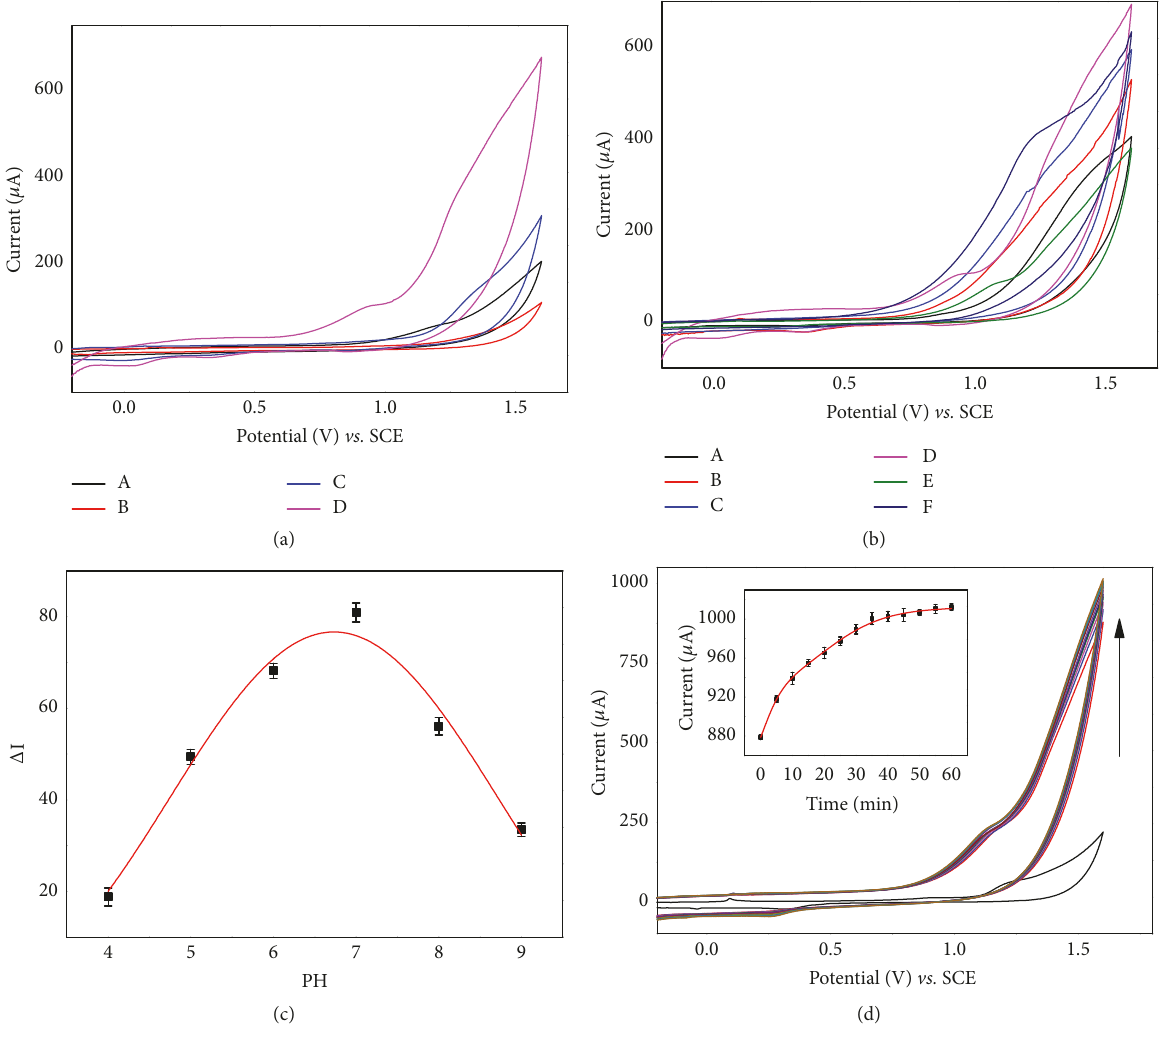
Figure 5: (a) CVs of different GCE under the absence (A and B) and presence (C and D) of 5mM H 2 O 2 in N 2 -saturated 0.1 M PBS (pH = 7.0) at a scan rate of 50mVs -1 . (A) Bare GCE (B and C) np-AuNPs/GCE, and (D) 4-carboxy-TEMPO-np-AuNPs/GCE. Optimization of experimental conditions: (b) CVs of the TEMPO -np-AuNPs/GCE in different pH values at the range of 2.0 ∼ 9.0 and (c) the relationship between the net current at 0.95V with different pH. (d) CVs of TEMPO-np-AuNPs/GCE in 0.1 M PBS (pH = 7.0), in the presence 5 mM H 2 O 2 , in different times from 0 min to 60 min, N 2 -saturated, 50mVs -1 . Inset: the changes of the electric current (1.6 V) with the time